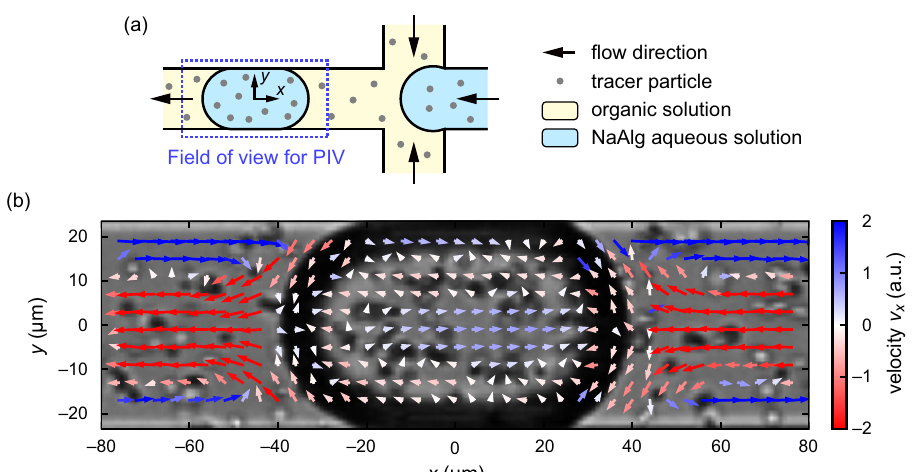
Figure 7. ( a ) Schematic illustration of the field of view for the PIV analysis, depicted by the blue dashed rectangle (not to scale). The droplet frame is adopted and the instantaneous center of mass of a flowing droplet is set as the origin. ( b ) Velocity field in the droplet frame inside and around the droplet flowing just after the junction. Color code corresponds to the velocity component in the x